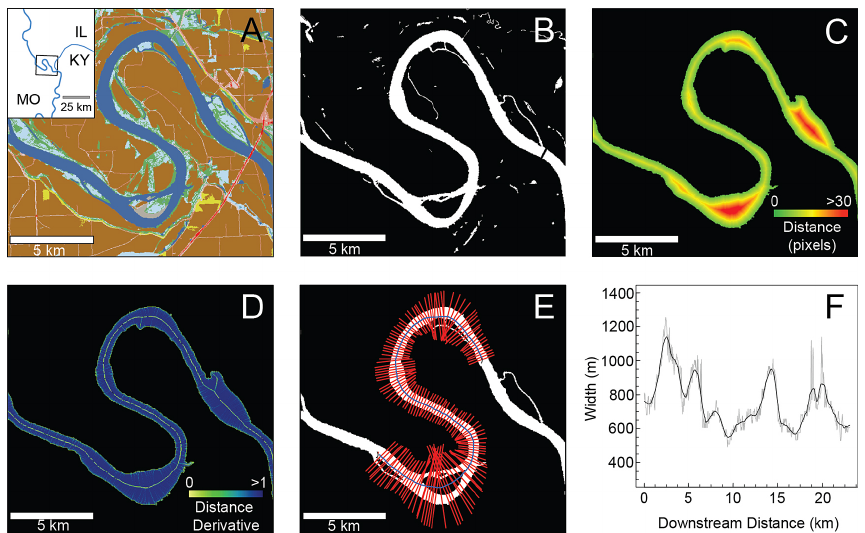
Figure 2. Inputs, intermediate steps, and products for calculation of river width in this study: (a) National Land Cover Dataset; (b) binary water mask of the open-water classification; (c) distance image based on a filled channel mask; (d) derivative of distance image used to calculate the centerline; (e) flow width measurements along orthogonal line segments to each centerline pixel; (f) plot of raw (gray) and smoothed (black) continuous